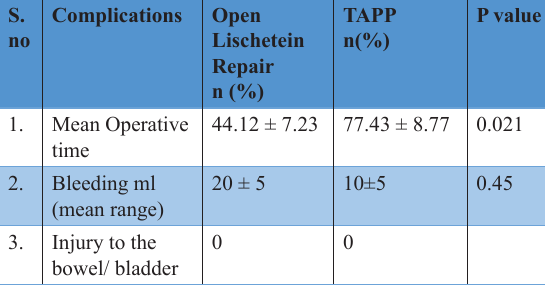
Journal of Society of Surgeons of Nepal J Soc Surg Nep. 2022;25(1)